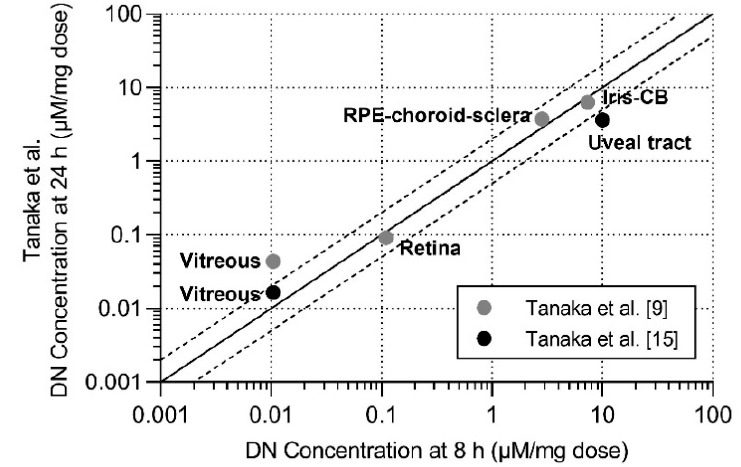
Figure 4. Comparison of dose-normalized (DN) results of levofloxacin ocular distribution between our study (x-axis) and two studies by Tanaka et al. (y-axis) performed with 14 C-levofloxacin [9,15]. The solid line is the line of identity and the dashed lines represent two-fold deviation.